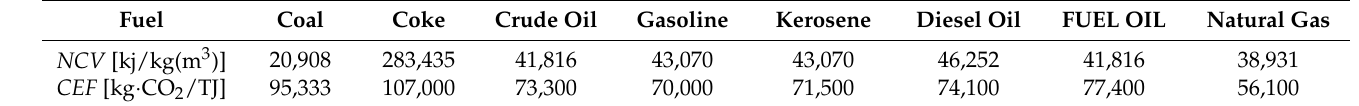
Table 1. Fuel, NCV , and CEF